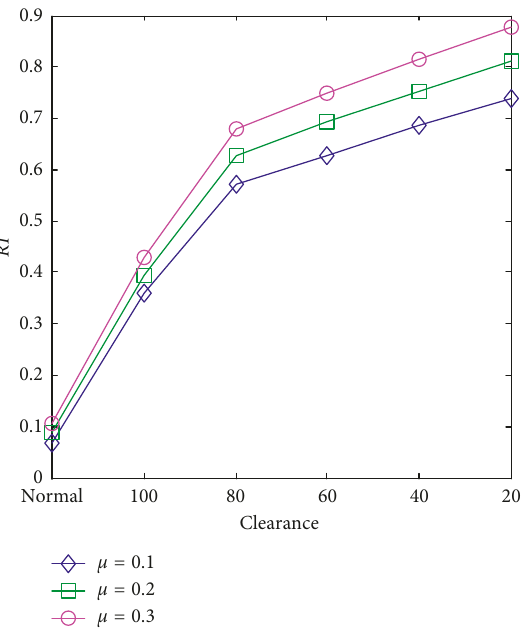
Figure 5: The trend of RI under different rub-impact clearances and friction